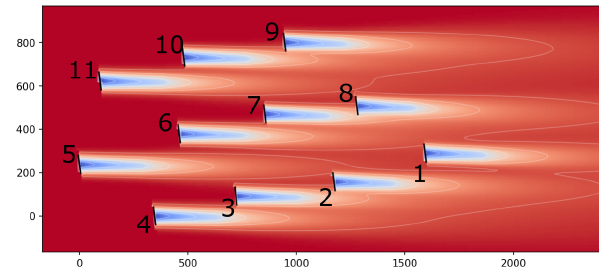
Figure 3. FLORIS model of the test site assuming the normal off- sets provided in the middle columns of Table 1 for the case of winds from 270 ◦